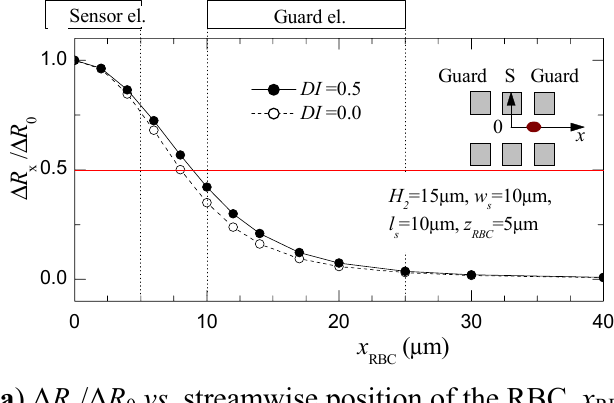
/ Δ R as the RBC passes between the electrodes; x 0 / Δ R , δ , and the deformation index x 0